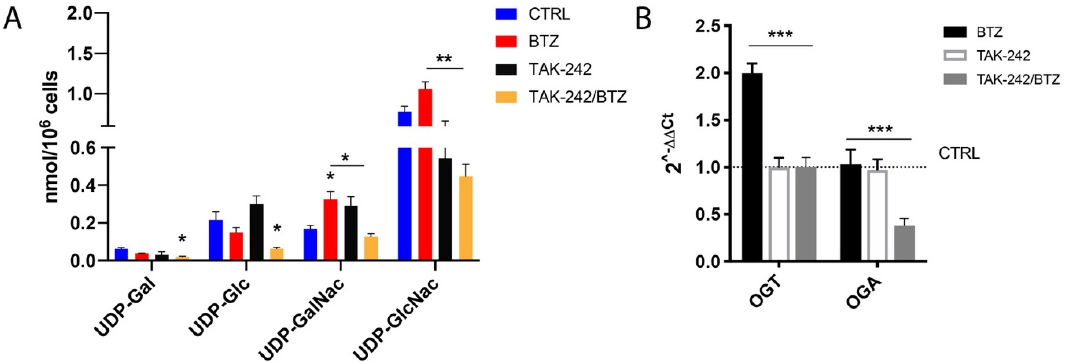
Figure 5. TAK-242/BTZ treatment impaired the hexosamine biosynthetic pathway. ( A ) Concentrations of glycosylated UDP-derivatives were calculated by HPLC analysis in deproteinized cells 24 h post-treatment with BTZ, TAK-242 or their combination. Values are the mean of three different experiments and are expressed as nmol/10 6 cells. UDP-Gal = UDP-galactose; UDP-Glc = UDP- glucose; UDP-GalNac = UDP-N-acetylgalactosamine; UDP-GlcNac = UDP-N-acetylglucosamine. ( B ) The mRNA transcription of OGT and OGA (relative to B2M) was determined by RTqPCR after